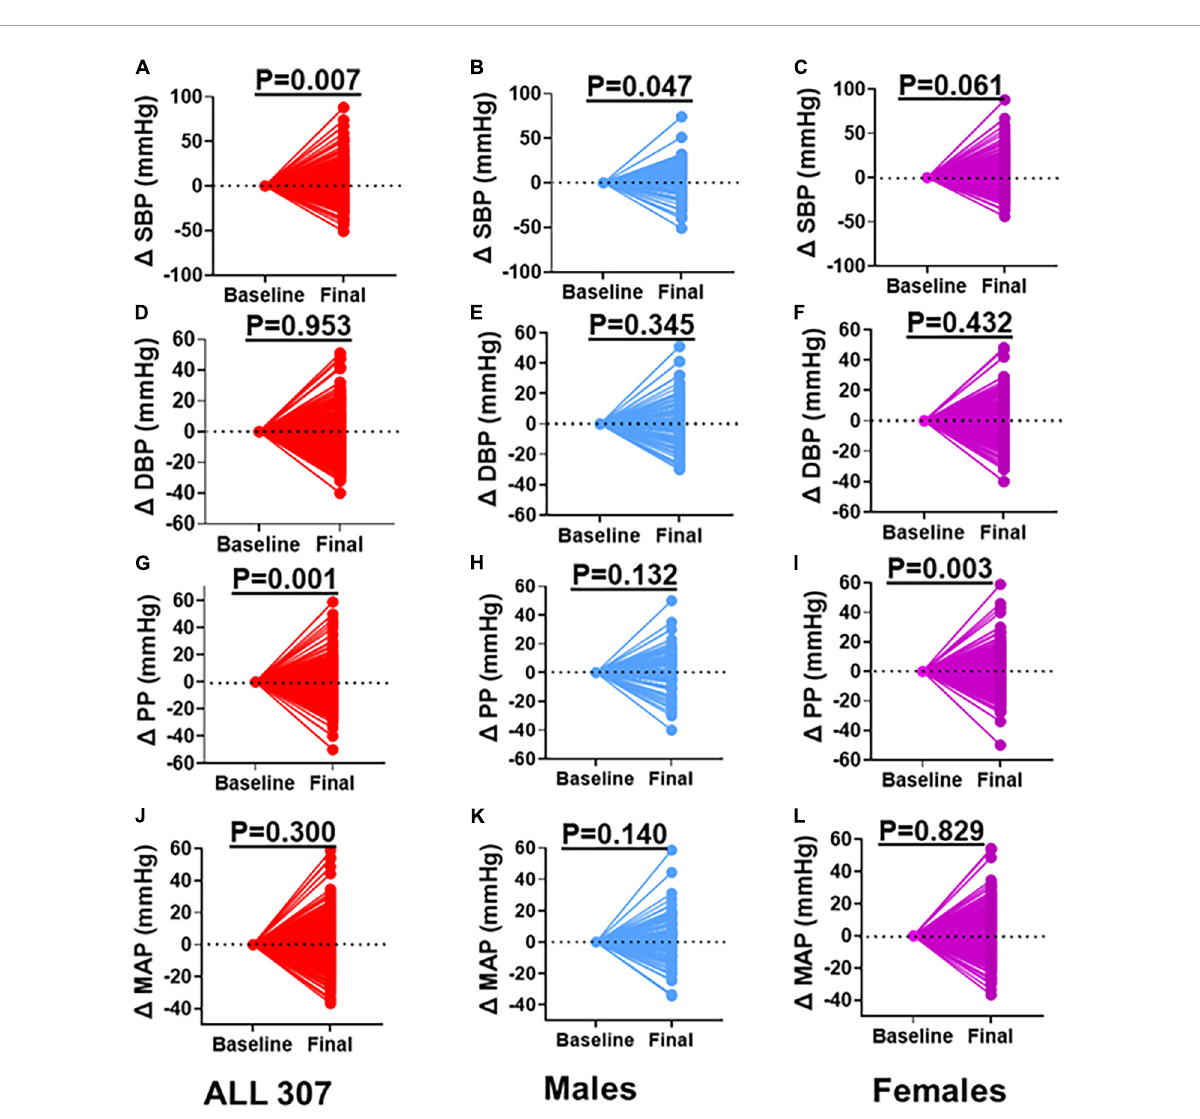
FIGURE2 Changes in Blood Pressure between Baseline and Final. (A) SBP all participants, (B) SBP males, (C) SBP females, (D) DBP all participants, (E) DBP males, (F) DBP females, (G) PP all participants, (H) PP males, (I) PP females, (J) MAP all participants, (K) MAP males, (L) MAP females: baseline values were zeroed and differences between final and baseline (delta) compared. Paired t -test was used to determine the P -values. SBP, systolic blood pressure; DBP, diastolic blood pressure; PP, pulse pressure; MAP, mean arterial pressure.